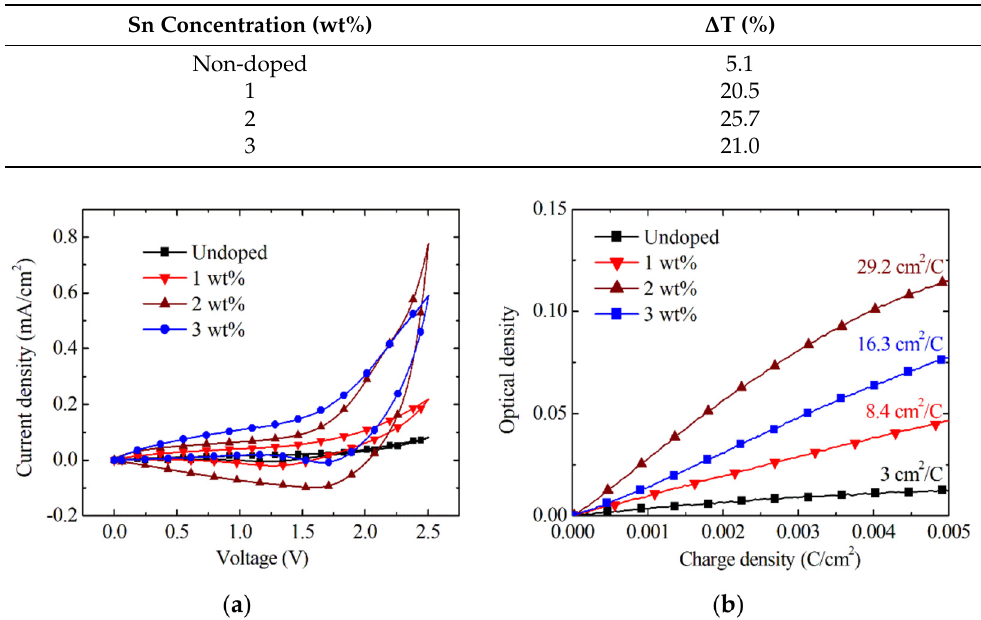
Figure 11. ( a ) Transmittance spectra measured after applying a voltage for 2 min and ( b ) response time of the EC device with 2 wt% Sn-doped NiO film (the dash lines indicate the time required for the transmittance to reach 0% to 90% or 100% to 10%). Table 1. Transmittance modulation of the EC device at 550 nm for different Sn concentrations in the NiO layer.